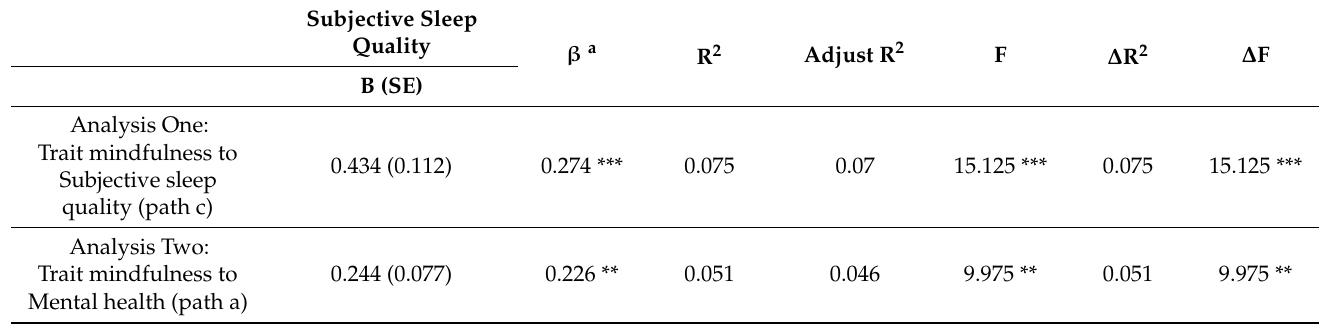
Table 3. Results of hierarchical regression analysis of the subjective sleep quality